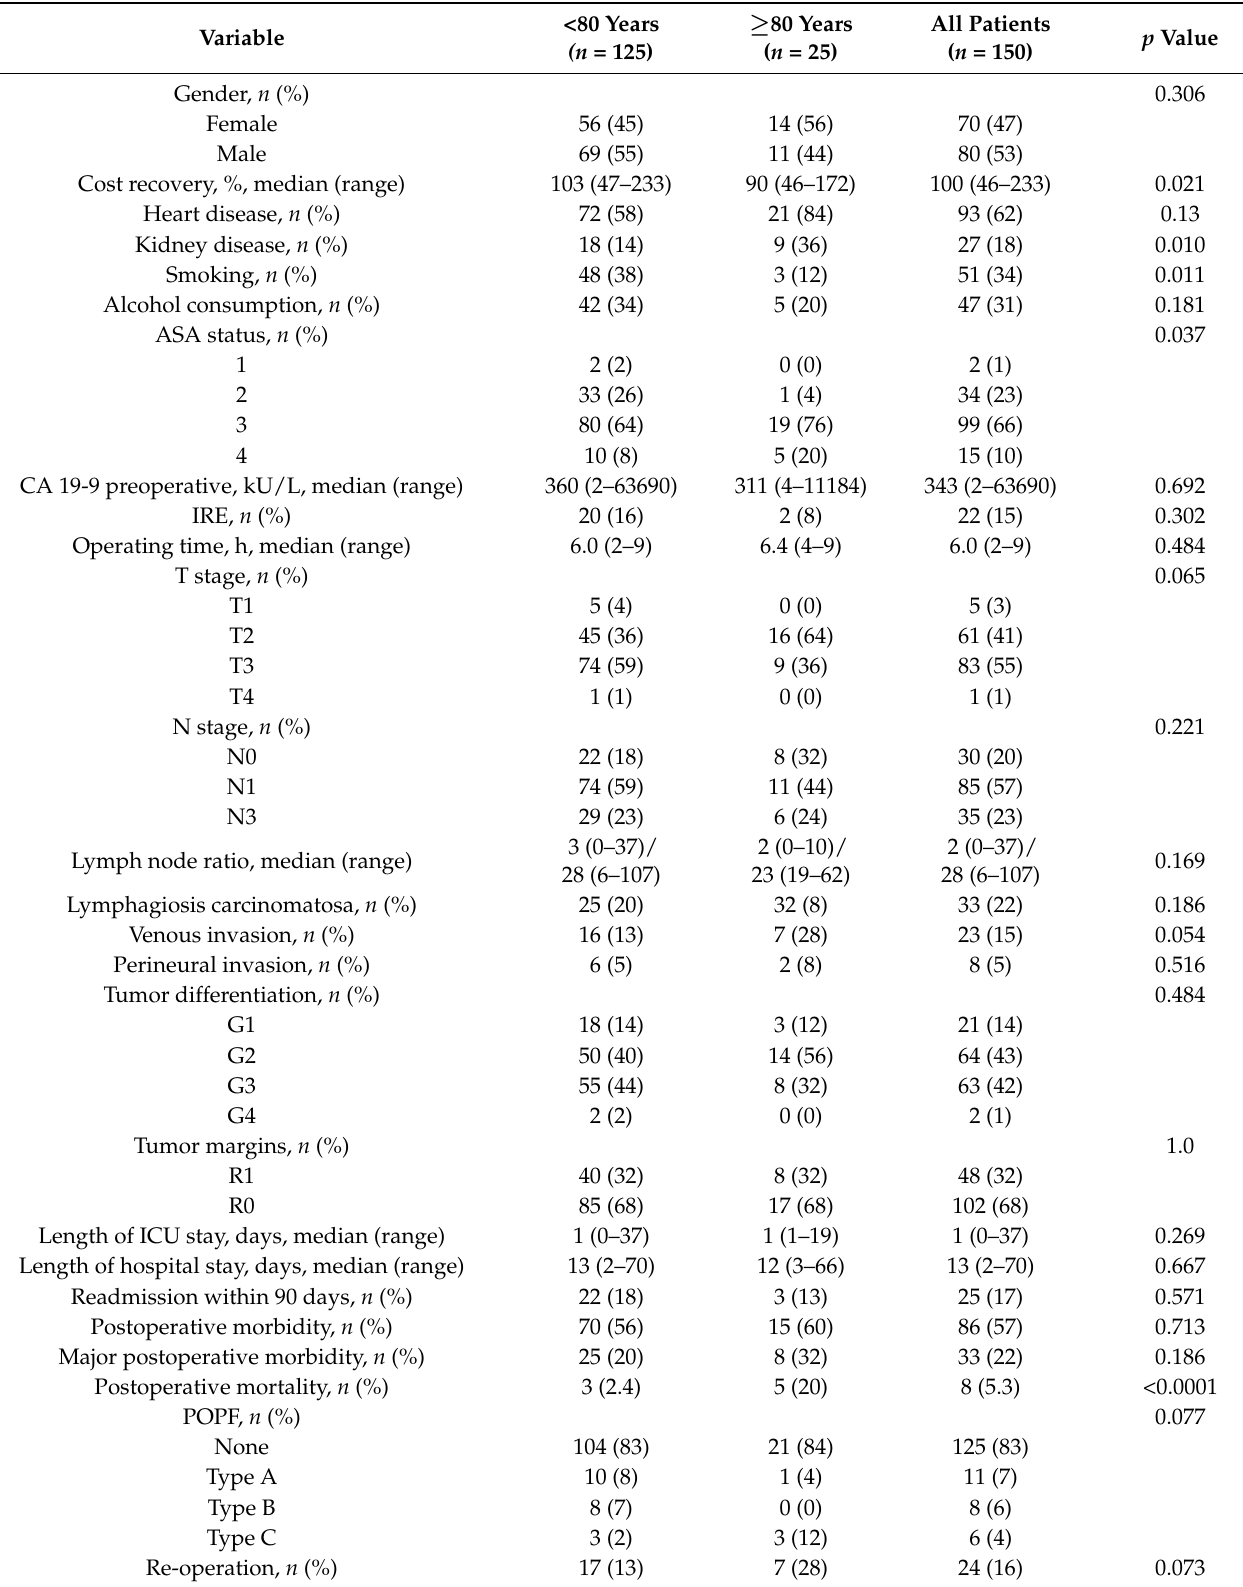
Table 3. Comparison of clinicopathological characteristics of 150 patients undergoing resection for pancreatic ductal adenocarcinoma according to patient